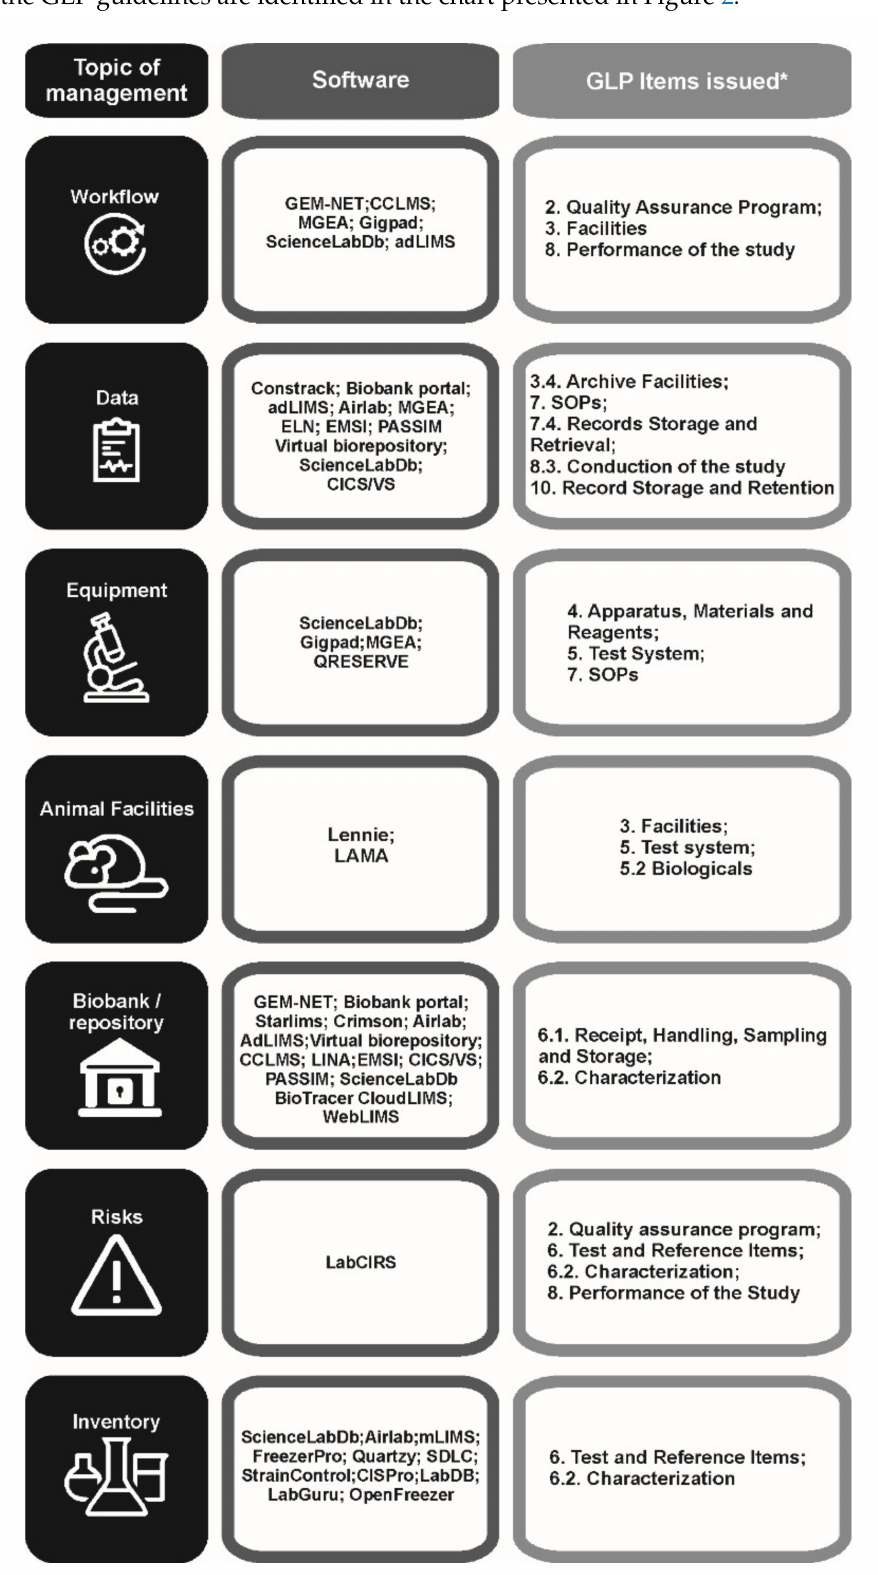
Figure 2. The main applications of the identified software on the different sections and chapters of the OECD GLP Principles